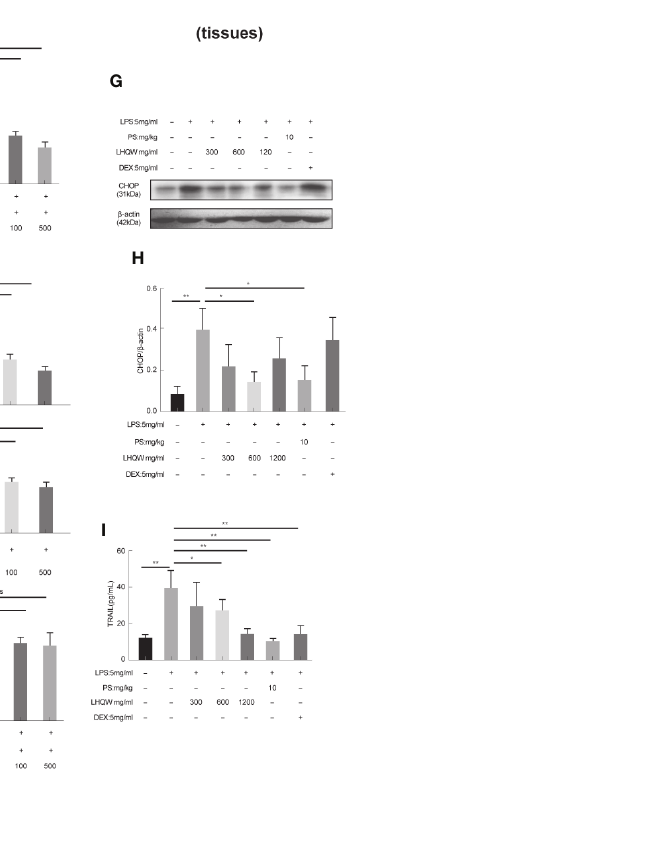
FIGURE 3 | Lian Hua Qing Wen capsule (LHQW) alleviated lipopolysaccharide (LPS)-induced endoplasmic reticulum stress (ERS) and tumor necrosis factor-related apoptosis-inducing ligand (TRAIL) expression in macrophages. Bronchoalveolar lavage fl uid (BALF) samples were centrifuged, and pulmonary macrophages were isolated with the adherent method. THP1 cells were fi rst induced by PMA to differentiate into macrophages, and subsequently treated with LHQW and LPS for another 24 h. (Togno-Peirce et al., 2013) In the cells, (A) LHQW inhibited the transcription of CHOP and TRAIL in THP1 cells detected by RT-PCR assays. (B) LHQW downregulated the expression of TRAIL secretion in the supernatant of THP1 cells detected by ELISA assay. (C) Treatment with the ERS inhibitor PBA reduced TRAIL concentration in the supernatant of THP1 cells. (D, E) LHQW inhibited the translation of CHOP and GRP78 in THP1 cells and RAW 264.7 cells detected by western blot. (F) Effect of LHQW treatment on the expression of DR5, the ligand of TRAIL, in HPA cells treated with the supernatant from THP1 cells. (G, H) The translation of CHOP in pulmonary macrophages. (I) The secretion of TRAIL in BALF. The data weas presented as the mean ± S.E.M. of three independent experiments. # P < 0.05 vs. the NC group. * P < 0.05, ** P < 0.01 vs. the LPS group. LHQW-L: 50 m g/mL; LHQW-M: 100 m g/mL; LHQW-H: 500 m g/mL.